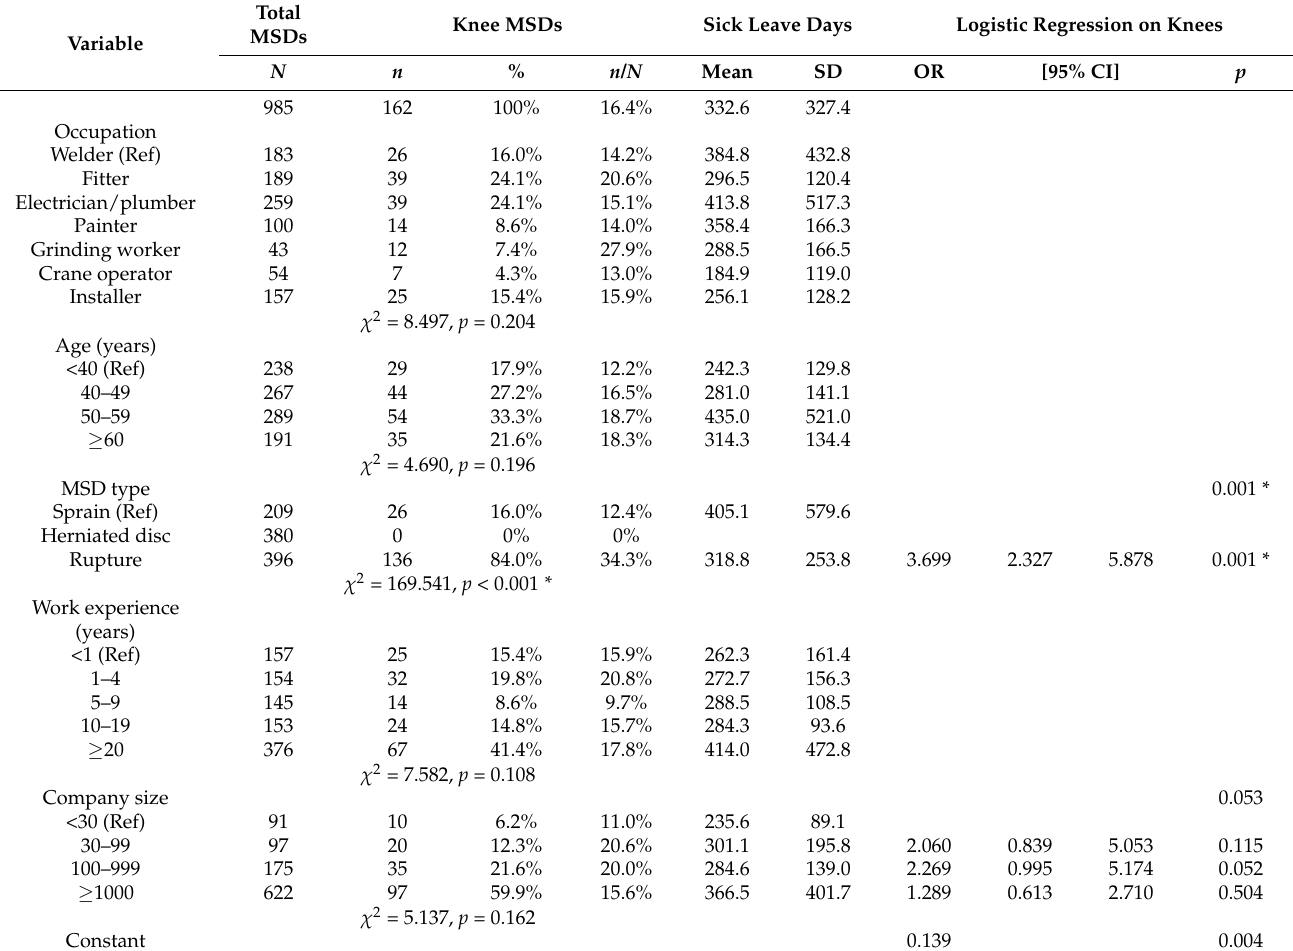
Table 6. Distribution and sick leave days of knee MSDs and factors associated with knee